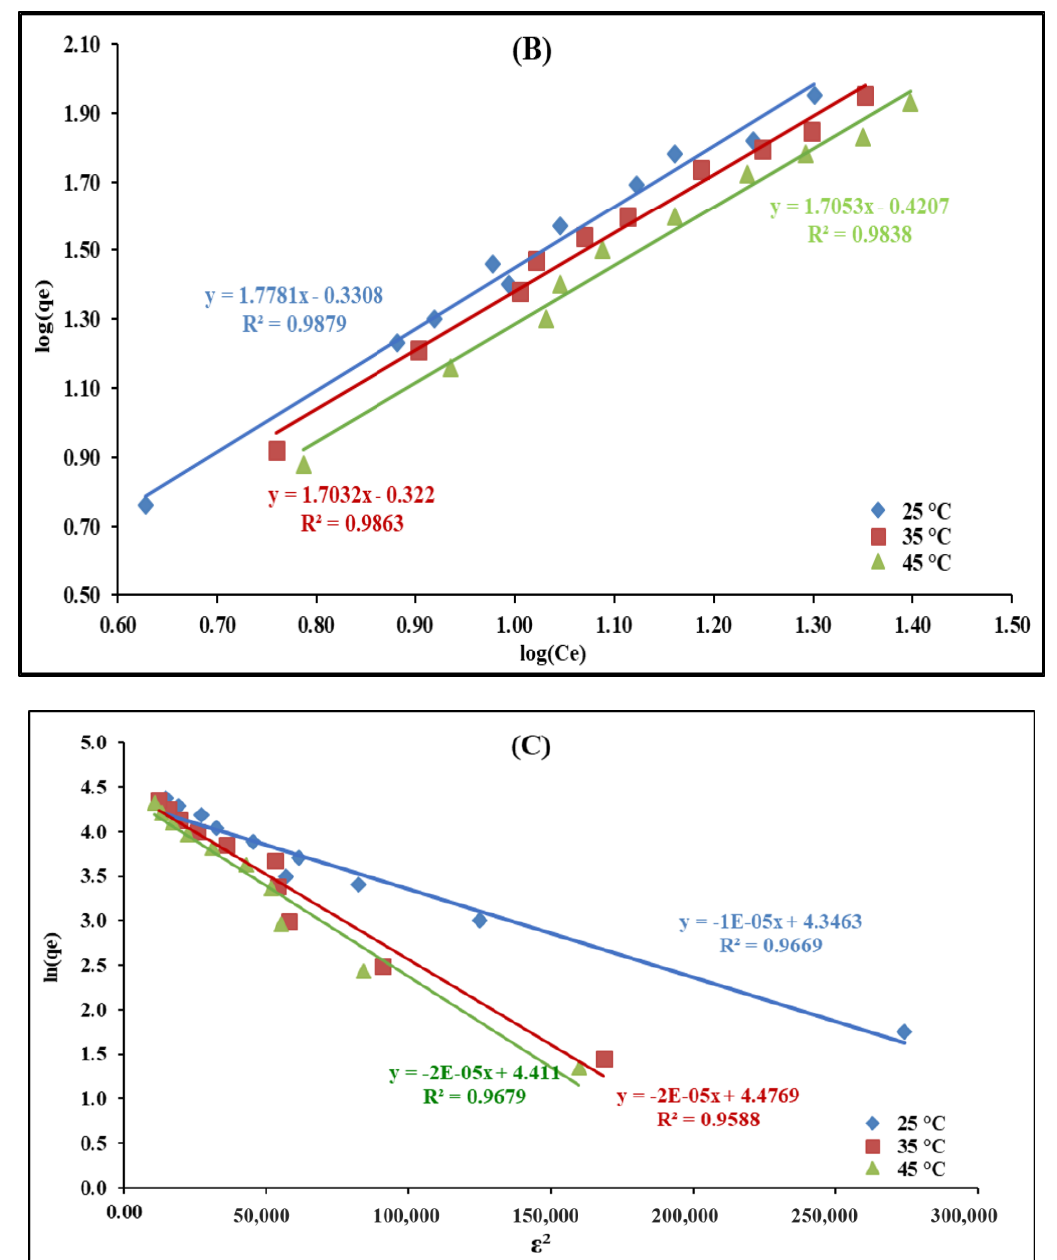
Figure 13. Linear adsorption ( A ) Langmuir(II) isotherm, ( B ) Freundlich isotherm, and ( C ) D-R isotherm of Th(IV), at pH 3.0 at 25.0, 35.0, and 45.0 °C. Table 4. Parameters Langmuir(II), Freundlich and D-R adsorption isotherm models at 25.0, 35.0, and 45.0 °C for U(VI) and Th(IV) ions onto CCsMFO nanocomposite, at pH 3.0.